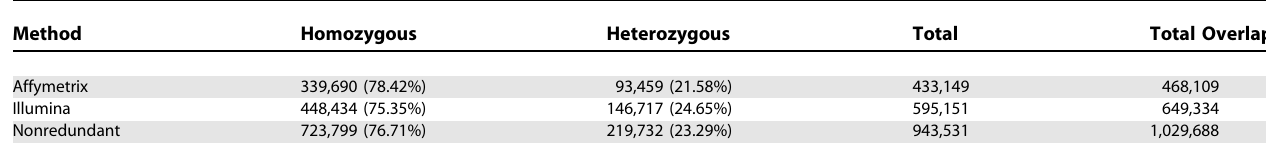
Table 8. Concordancy in SNP Genotyping Validation Comparing Independent Genotype Calls Using Affymetrix 500K, Illumina HumanHap650Y in Comparison with Sequence from the HuRef Assembly